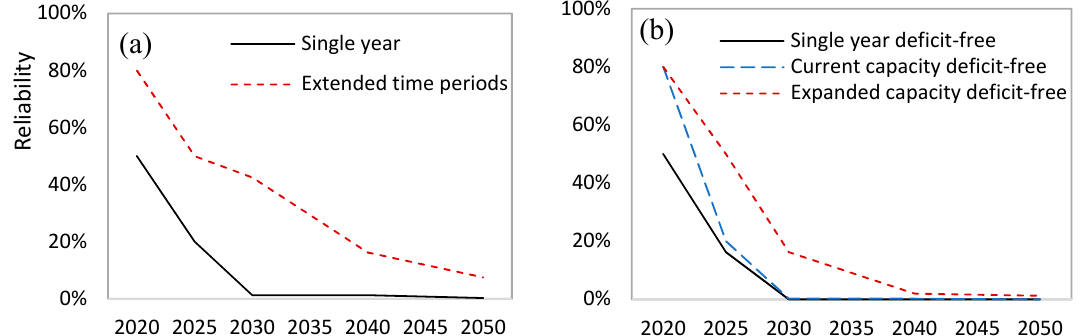
Figure 8. Single-year planning reliability and extended planning reliability, both with temporary deficits ( a ) and deficit-free ( b ).